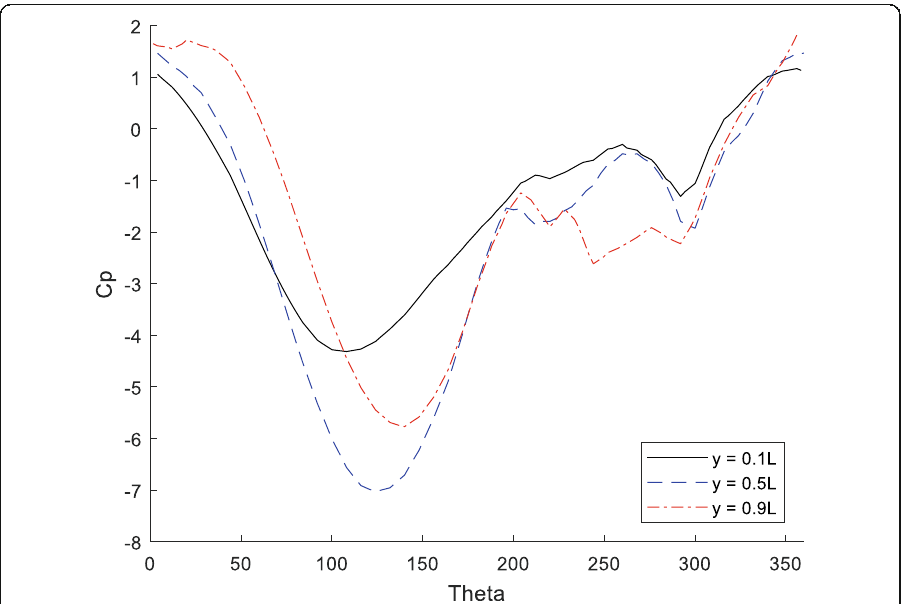
Fig. 6 Distribution of pressure coefficient on the Magnus blade at different spanwise locations for AR =